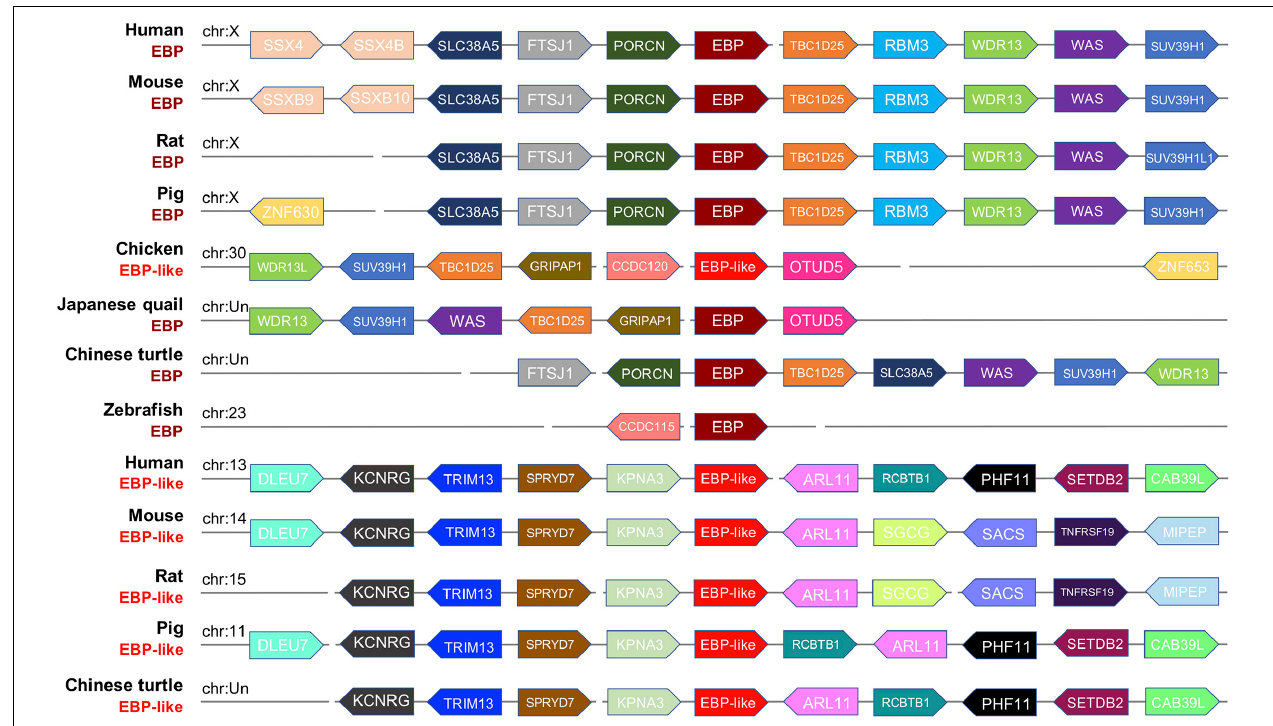
FIGURE 3 | Syntenic relationship of gene loci mapped around the EBP / EBP-like gene in selected species. The gene name, species and chromosome distribution are listed on the left. Every pentagon refers to a gene, and the same color in columns means the same gene existing in the corresponding species. The direction represents DNA strand for gene transcription, right refers to sense strand, left refers to antisense strand.